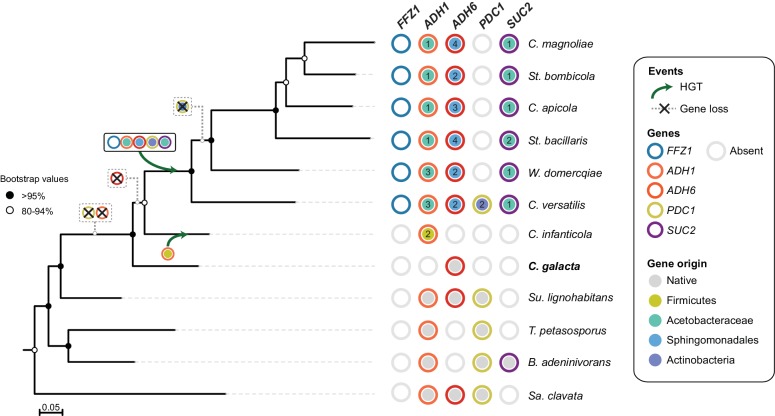
Loss and acquisition of sugar metabolism related genes in the W/S clade and closely related lineages.Phylogenetic relationship between W/S species and closest relatives are depicted based on the ML phylogeny using the same dataset as in Figure 2A, but with the addition of C. galacta. For each of the four relevant genes: ADH1, ADH6, SUC2, and PDC1, presence, absence, and the native or bacterial origin of the orthologs found in the cognate draft genomes are shown for each species next to the respective branch of the tree. Each gene is represented by circles with different line colors (blue for previously studied FFZ1 (Gonçalves et al., 2016), orange for ADH1, red for ADH6, yellow for PDC1, and purple for SUC2). For xenologs, the different predicted bacterial donor lineages are denoted by different fill colors as indicated in the key. For W/S-clade species, the number of paralogs found in the cognate draft genome is also shown. Inferred gene losses (cross) and HGTs events (arrows) are indicated in the tree using the same color codes.